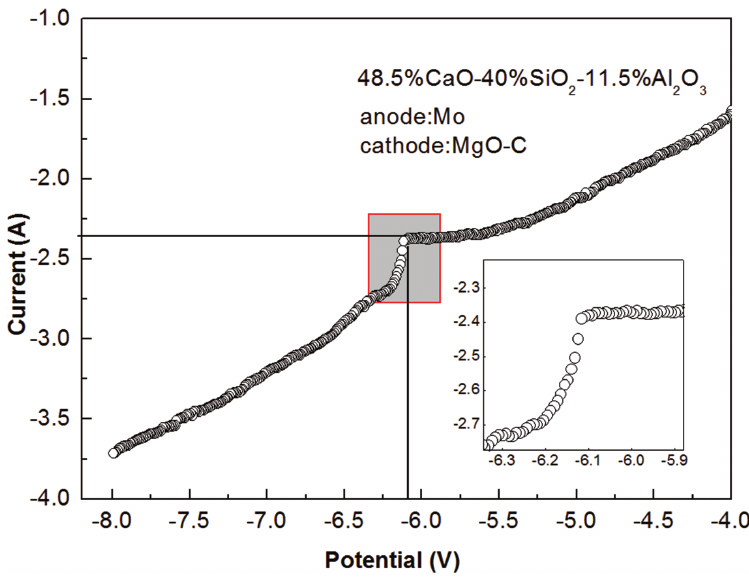
Figure 2: LSV curve in CaO-SiO 2 -Al 2 O 3 slag